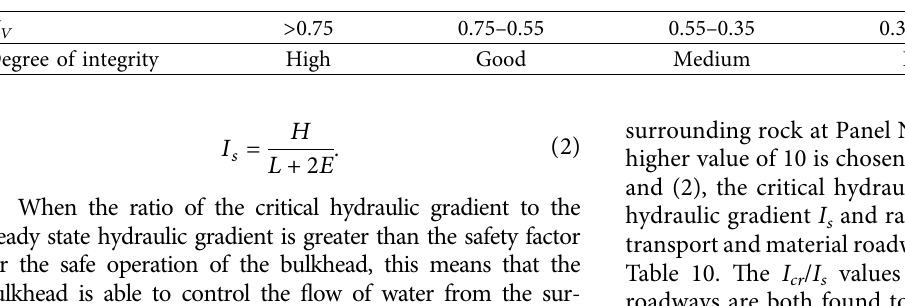
Table 8: Values of K V for different rock mass